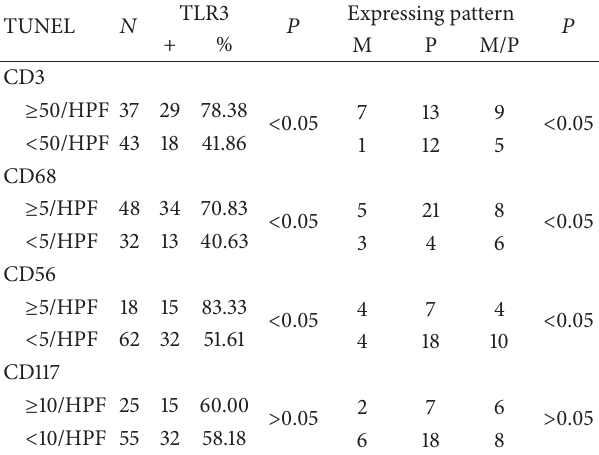
Table 4: Association of TLR3 expression with interstitial immuno- reactive cells.